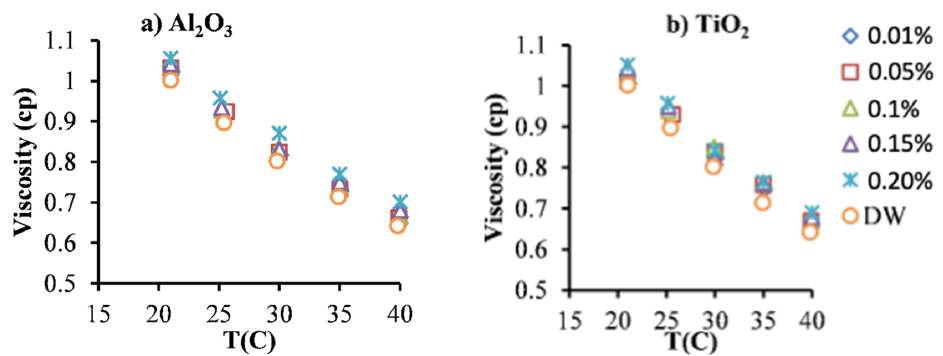
Figure 2. Viscosity of NFs as a function of temperature for two types of nanoparticles: ( a ) Al 2 O 3 , and ( b ) TiO 2 .